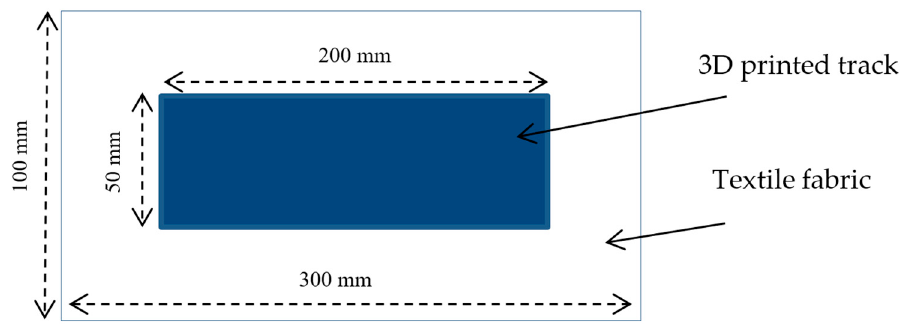
Figure 2. Scheme of the polymer 3D-printed onto textiles for mechanical tests. Table 4. 3D printing parameters.